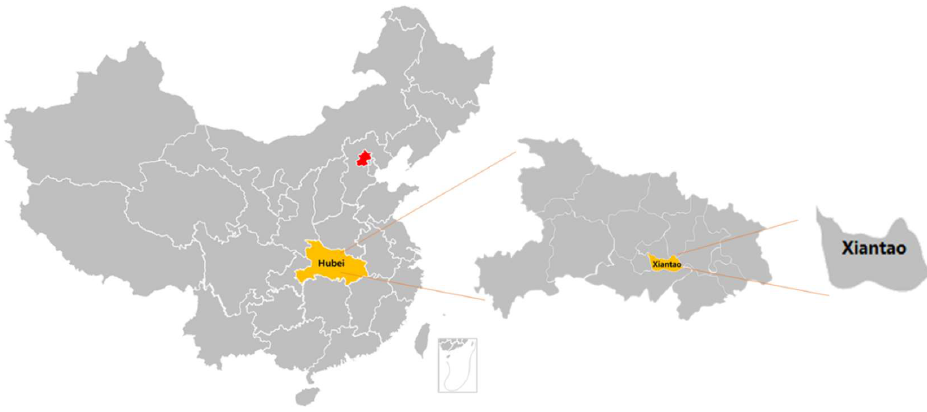
Figure 1. Location of sample city.